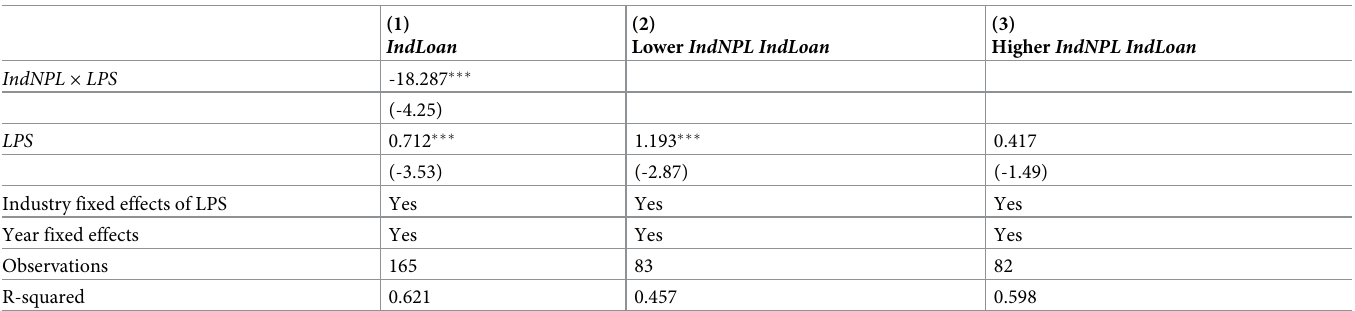
Table 4. The largest private shareholder, the industry’s NPL ratio and bank loans. This table reports the estimation results from OLS regressions analyzing the impact of the largest private shareholder on bank lending to their industry, with a different level of the bank’s NPL ratio in their industry in each column. Columns 1–3 uses IndLoan as the dependent variable. Variables are defined in S1 Appendix. The sample period is from 2007 to 2020. In parentheses are t-statistics. ��� , �� , � indicate statisti- cal significance at the 1%, 5%, and 10% level, respectively.